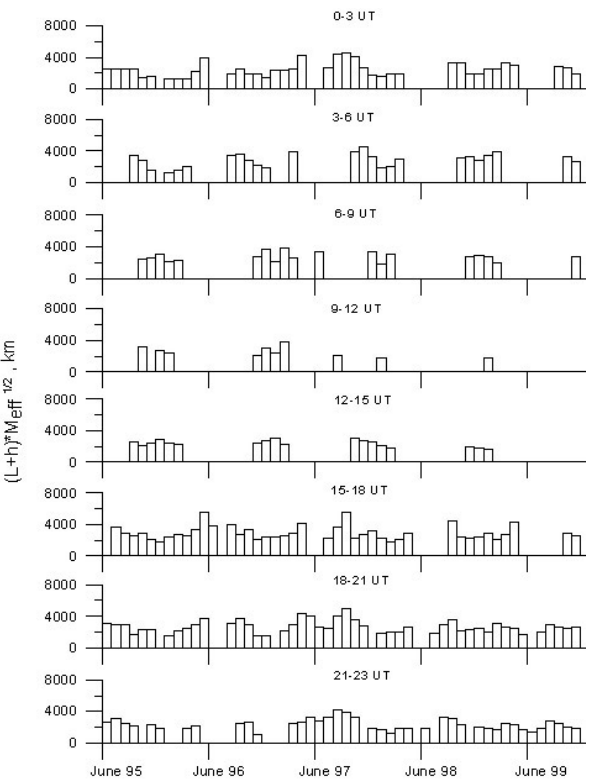
Fig. 6. Values of the SRS frequency scale during 1995–1999 calcu- lated on the basis of the IAR theory using the IRI model adapted to the values of N emax shown in Fig. 5a.